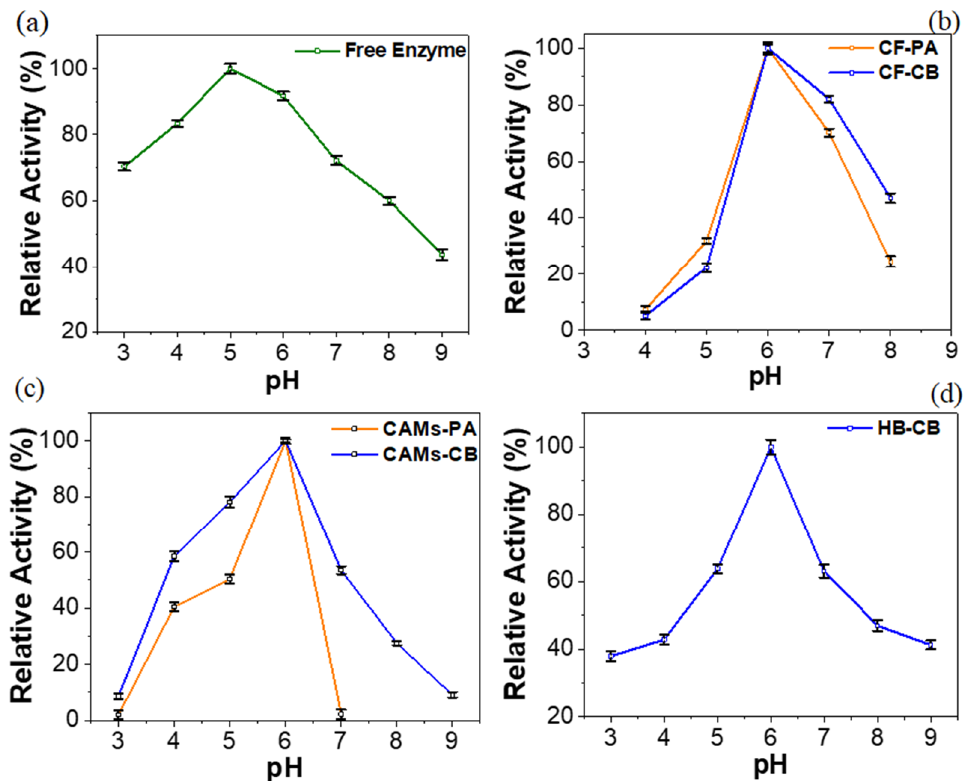
Figure 3. Effect of pH (3.0–9.0) on the radish peroxidase activity. ( a ) Free enzyme. Immobilized biocatalysts Figure 3 . Effect of pH (3.0-9.0) on the radish peroxidase activity. ( a ) Free enzyme. Immobilized 152 byphysicalAdsorption(PA)andcovalentBinding(CB)techniques: ( b )coconutfiber(CF),( c )calciumalginate biocatalysts by physical Adsorption (PA) and covalent Binding (CB) techniques: ( b ) coconut fiber 153 microspheres (CAMs), ( d ) SBA-15 / albumin hybrid (CF), ( c ) calcium alginate microspheres (CAMs), ( d ) SBA-15/albumin hybrid (HB). 154